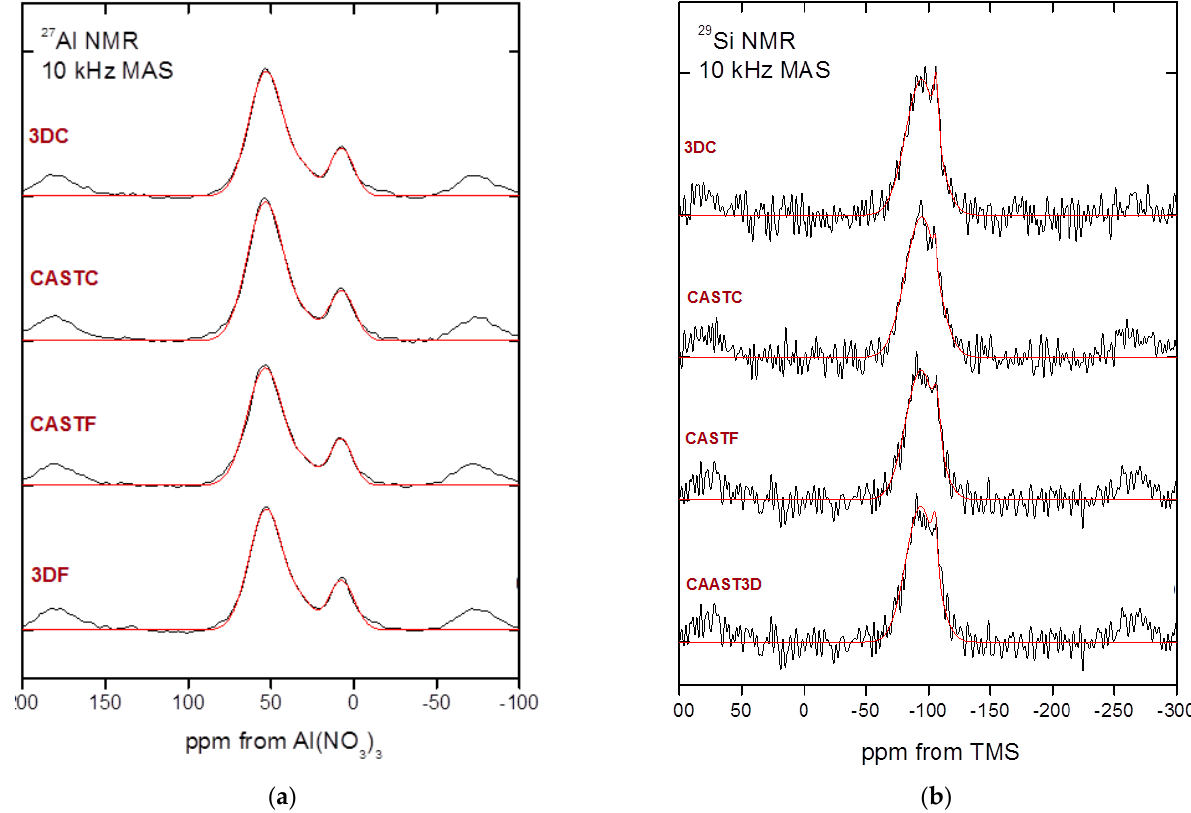
Figure 4. The results of NMR analysis for: ( a ) aluminum; ( b ) silica. Aluminate anions, four-coordinated aluminum (with respect to oxygen) resonate at 60–80 ppm, and that in silico-aluminates, four-coordinated aluminum resonates at approximately 50 ± 20 ppm while six-coordinated aluminum resonates at about 0 ± 10 ppm from [Al(H 2 O) 6 ] 3+ [66,67]. The 27 Al chemical changes, presented in Figure 4 and Table 5, in the range of ca. 55 ppm from [Al(H 2 O) 6 ] 3+ indicate that the aluminum is of the AlQ4(4Si) type and is tetrahedrally coordinated. The 29 Si MAS-NMR is represented by two peaks (Figure 4). The major band at ca. − 94 ppm, is connected with the presence of a SiQ4 (2Al) unit and the second band at − 115 ppm is related to unreacted silica-fume-SiO 2 (Table 5). The second component is probably the result of sand addition